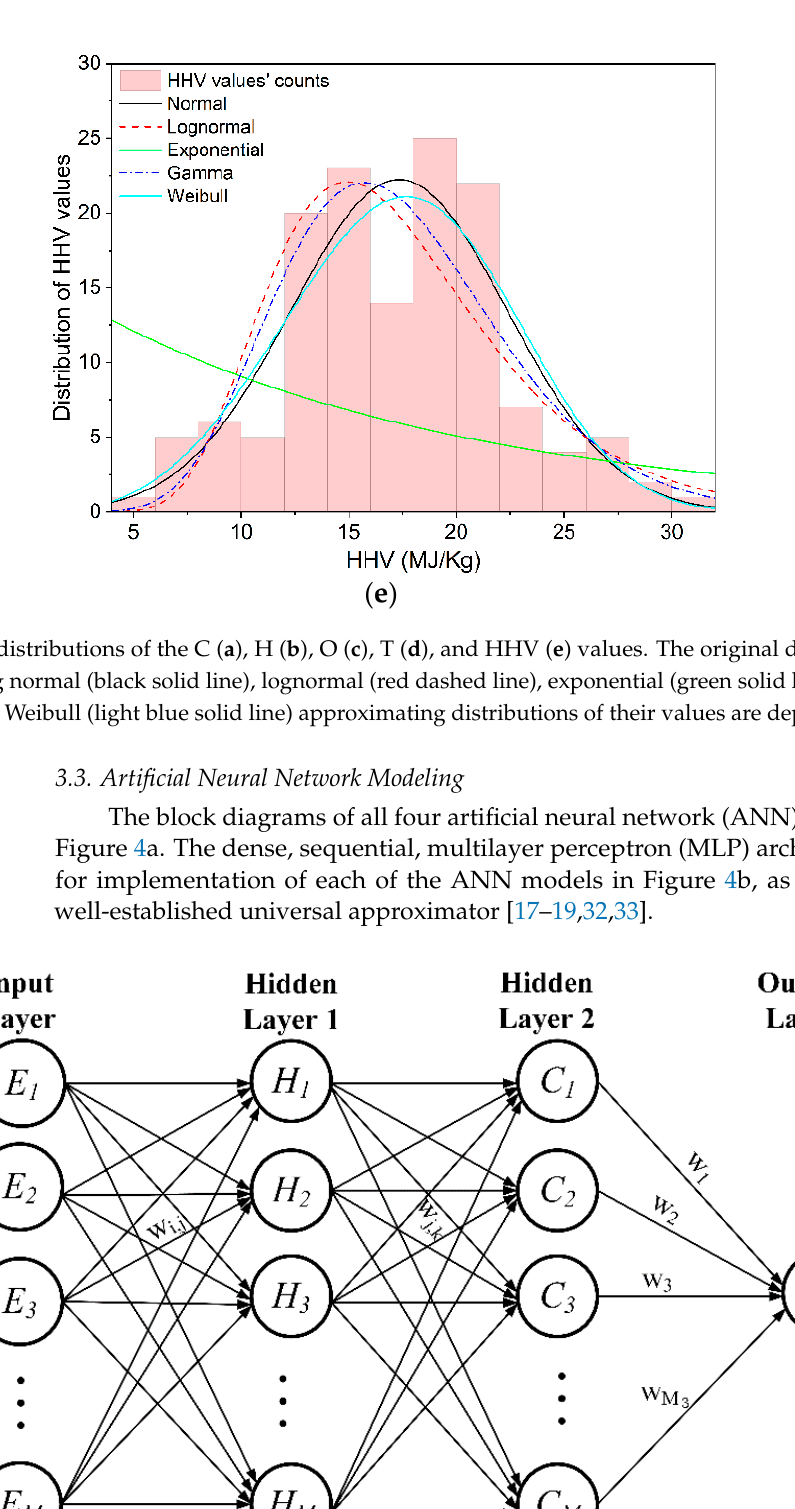
Figure 3. Plots of the distributions of the C ( a ), H ( b ), O ( c ), T ( d ), and HHV ( e ) values. The original data (bar diagrams) and the corresponding normal (black solid line), lognormal (red dashed line), exponential (green solid line), Gamma (blue dash-dotted line), and Weibull (light blue solid line) approximating distributions of their values are depicted in each case.